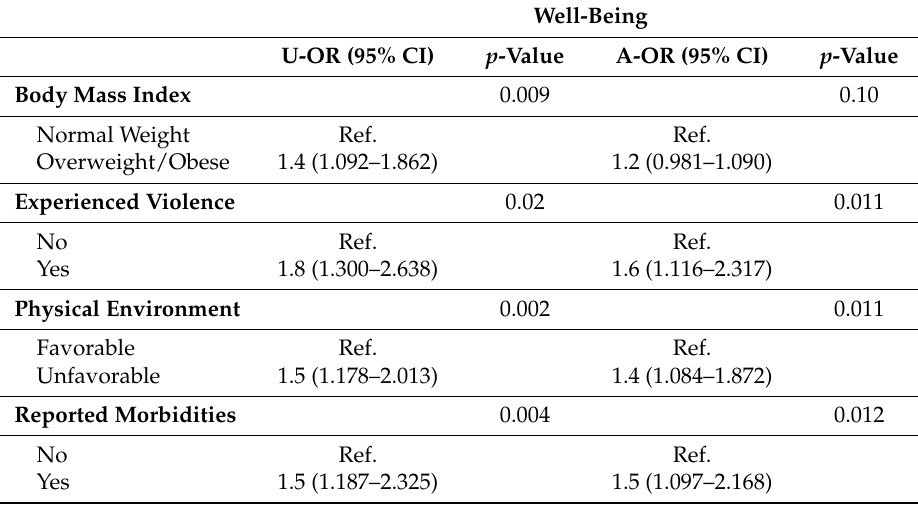
Table 3. Adjusted and un-adjusted Odds Ratios (OR) for “ill-being/likely depression” compared to “moderate to high” well-being among Saudi women (N =